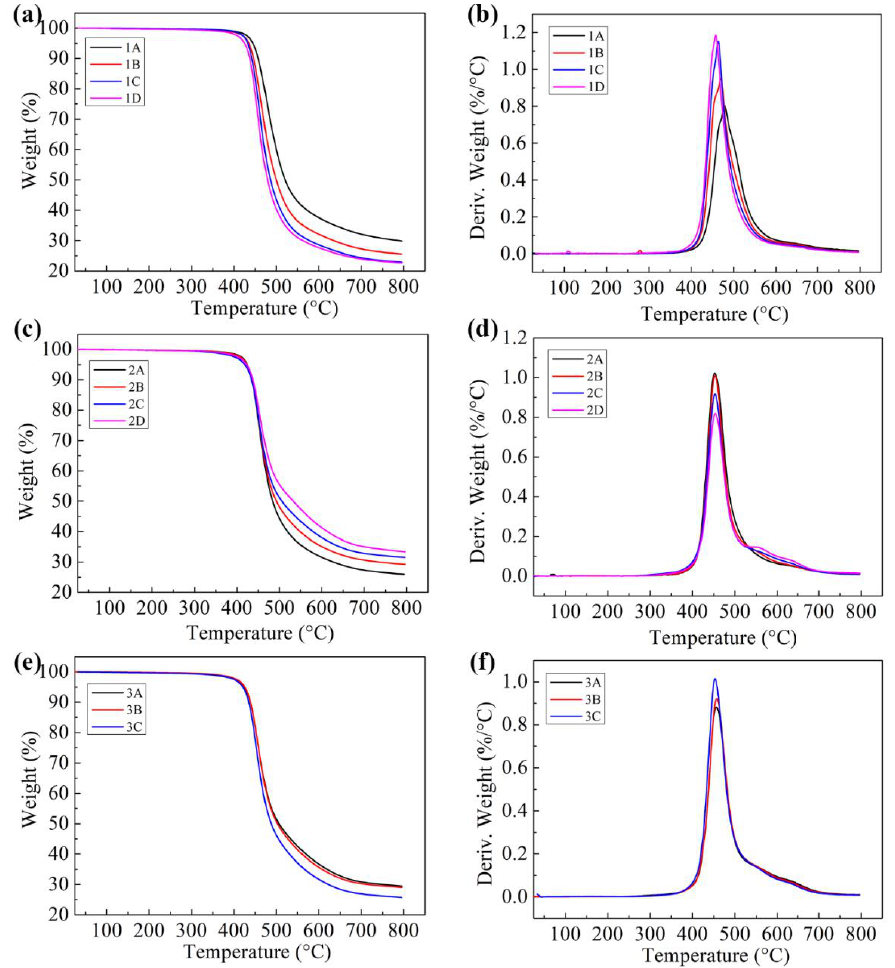
Figure 5. TG and DTG curves of different modified BMI adhesives: ( a , b ) epoxy-modified BMI resin; ( c , d ) PEK-C-toughened epoxy-modified BMI resin; and ( e , f ) PEK-C/core–shell polymer co-toughened epoxy-modified BMI resin. Table 2. Characteristic heat resistance data of the BMI adhesives.